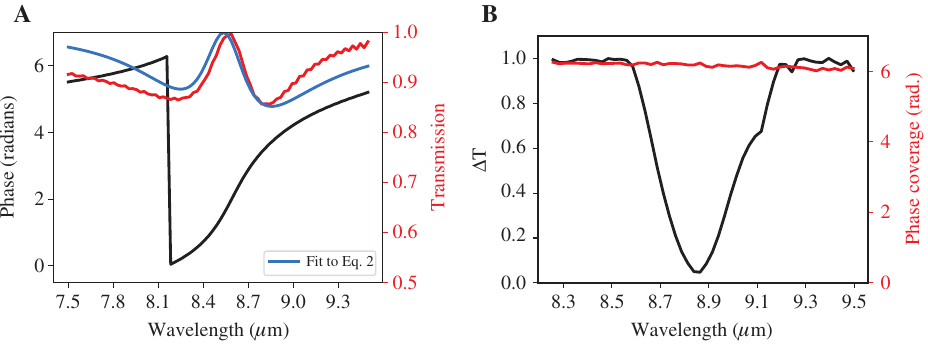
Figure 2: Transmission characteristics of single meta atom and bandwidth of the meta device. (A) FDTD-simulated amplitude and phase for a cross-resonator with arm length L = 3 μ m; curve-fitting to Eq. (2) is plotted by the blue line. (B) Maximum change in the transmission Δ T and phase coverage among the eight chosen